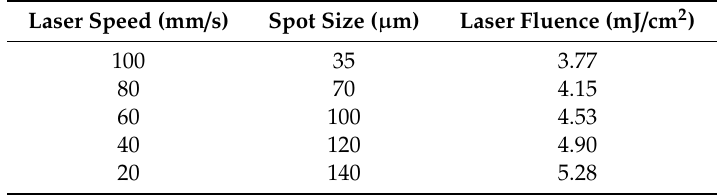
Table 3. Defocused laser beam condition.